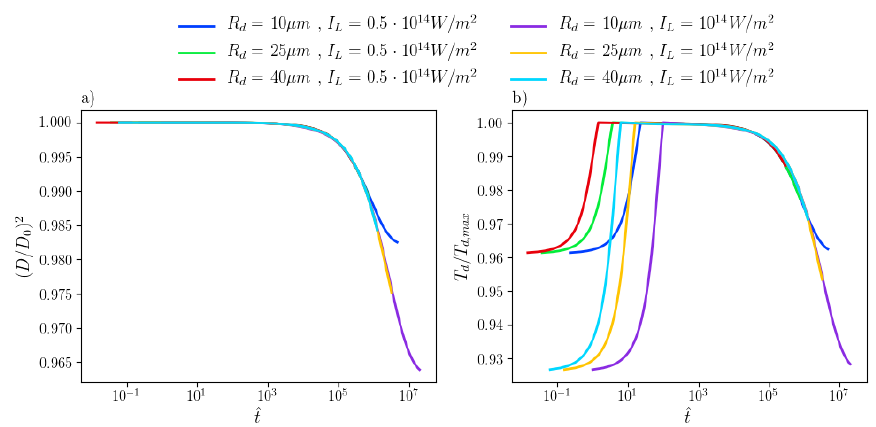
Figure 12. Temporal evolution of ethanol droplet parameters for cases shown in Table 1; ( a ) normal- ized surface area, ( b ) droplet temperature normalized by maximum temperature. The normalized time ˆ t = t ( I L 0 /10 14 ) 2.11 / R 2 D 0